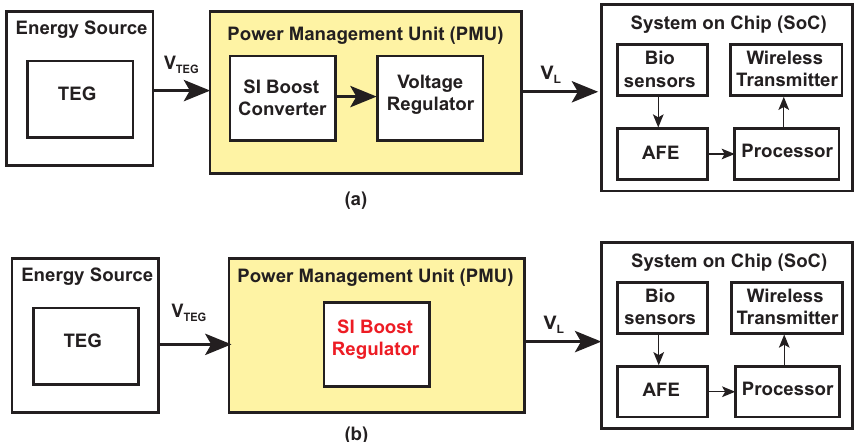
Figure 1. Block diagram of self-powered device using TEG energy harvesting where PMU includes ( a ) two blocks of boost converter to boost the V TEG and, voltage regulator to regulate the V L [19] and ( b ) one block of the proposed boost regulator that boosts the V TEG and regulates V L , simultaneously. To achieve regulation against the change in input voltage and/or load current, a control feedback loop is required. Pulse width modulation (PWM) is a common control technique that regulates the output voltage in SI converter [21]. Conventional PWM consists of an error amplifier, a ramp generator, and a comparator. The error amplifier generates a volt- pulse width signal with a duty cycle. This requires to carefully design a linear